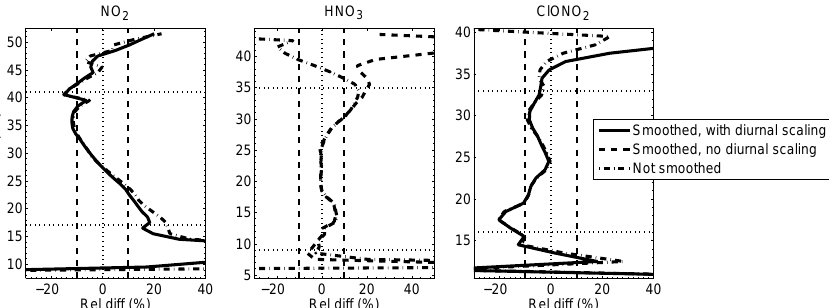
Figure A1. Weighted-average relative difference profiles for vertically smoothed (solid and dashed) and non-smoothed (dot-dashed) NO 2 , HNO 3 , and ClONO 2 data. The only profiles that do not include diurnal scaling are those for HNO 3 . Horizontal dotted lines indicate altitude limits within which the ACE-FTS comparisons yield average correlation coefficients greater than 0.8 and average standard deviations below